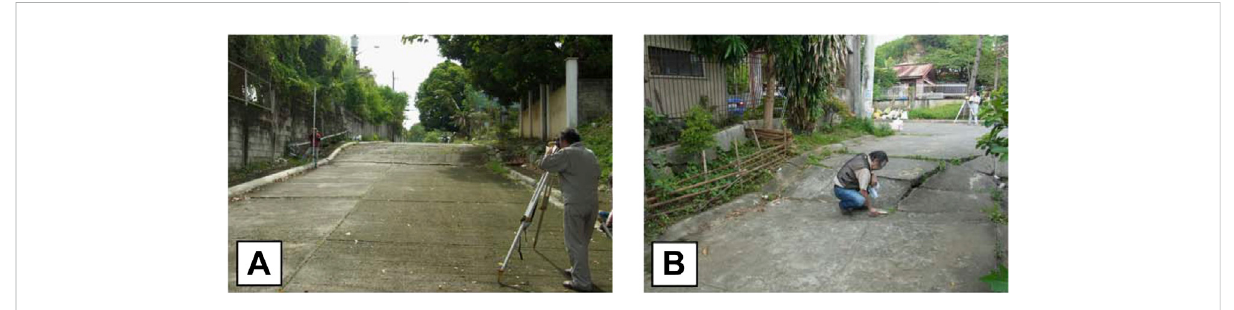
FIGURE 3 PrecisemeasurementofdisplacementacrossthecreepingtraceoftheWestMarikinaValleyFault(WMVF)atthesouthernmostsurveysitesat